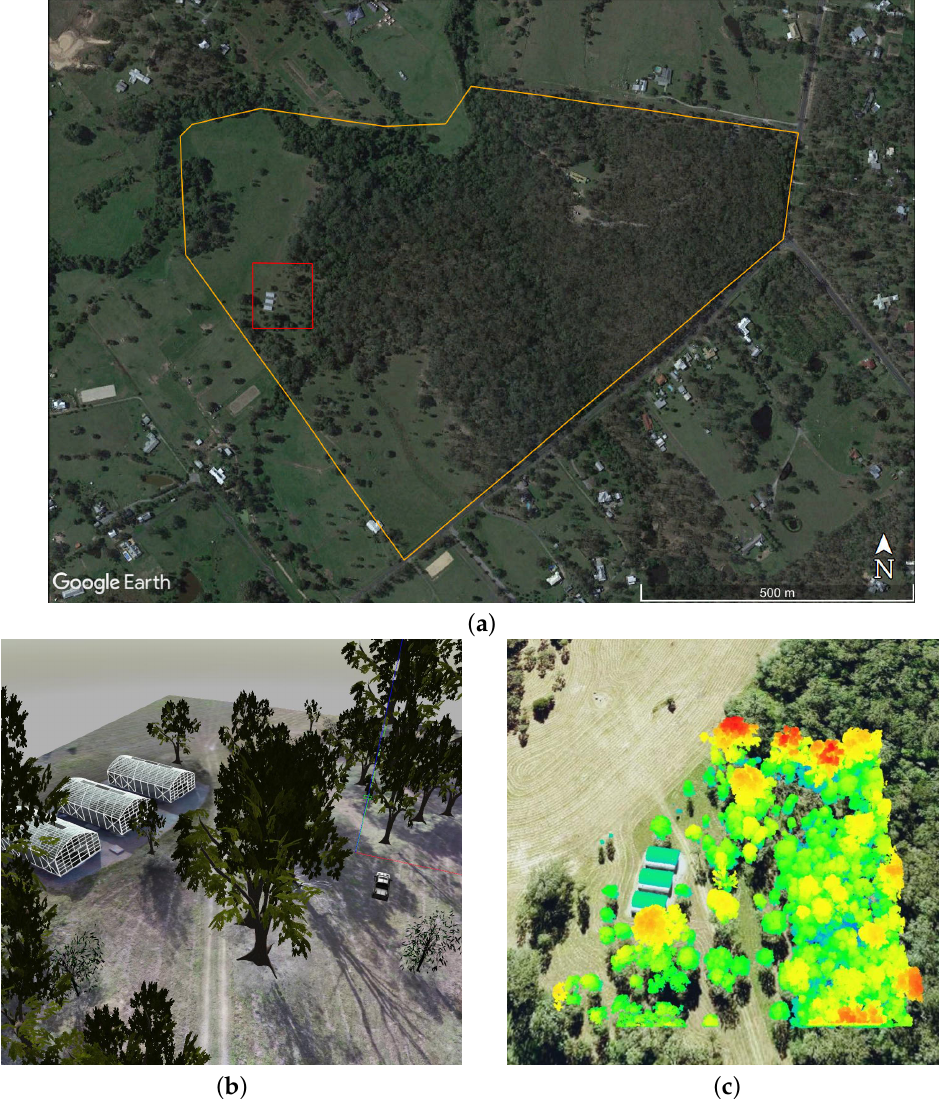
Figure 7. QUT Samford Ecological Research Facility (SERF) virtual environment setup. ( a ) Property boundaries of SERF (orange) and simulated region of interest (red). ( b ) Isometric view of the virtual SERF instance in Gazebo using a high-resolution red, green, blue (RGB) mosaic as the terrain texture. ( c ) Collected georeferenced LiDAR at SERF using a Hovermap mapper (Emesent Pty Ltd., QLD, Australia). LiDAR data are used to set accurate building and tree canopy heights in the simulated